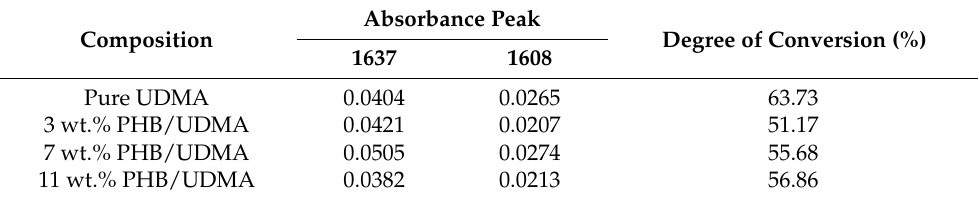
Table 4. Peak heights and resulting DC (%) for 3D printed UDMA and PHB/UDMA.